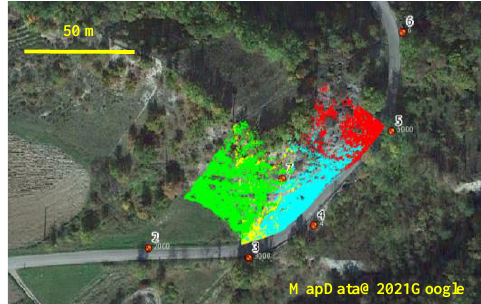
Figure 3. The four partially overlapped M60 scans. Google Satellite Data (MapData@2021Google) is used as background.